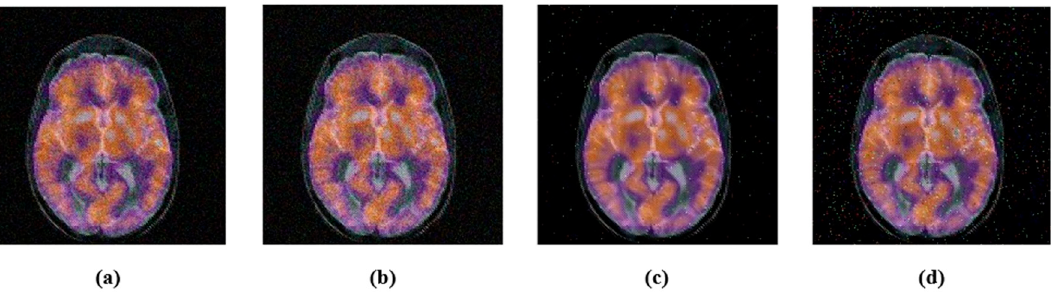
Figure 6. Image after adding noise attack: ( a ) Gaussian-noise 0.005, PSNR = 21.4300; ( b ) Gaussian- noise 0.02, PSNR = 20.8392; ( c ) salt and pepper noise 0.005, PSNR = 27.0980; ( d ) salt and pepper noise 0.02, PSNR = 22.9251.